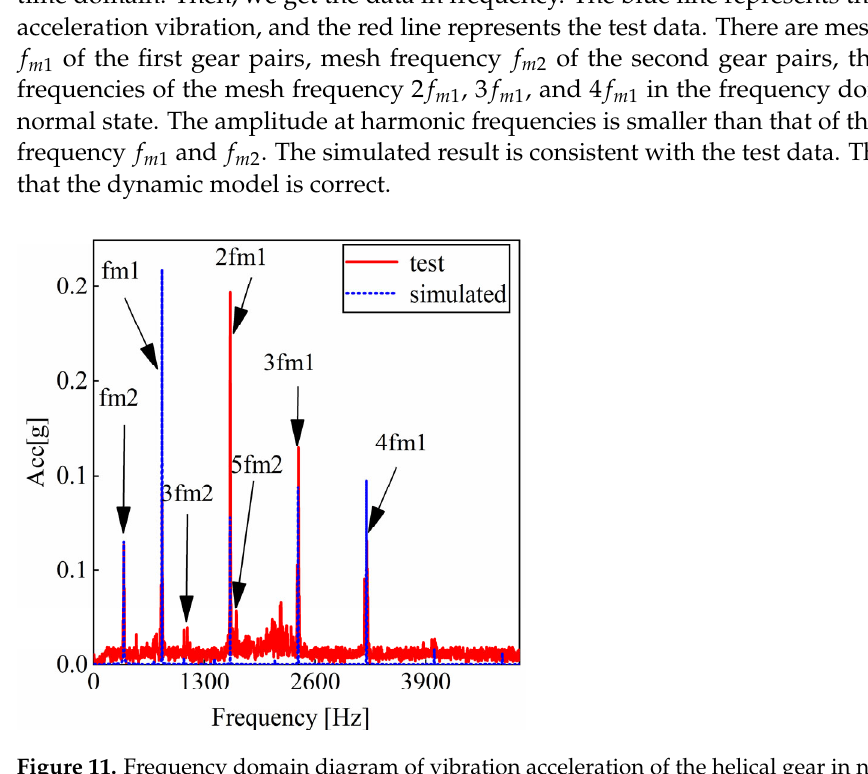
Figure 10. Time domain diagram of vibration acceleration of the helical gear in normal state.